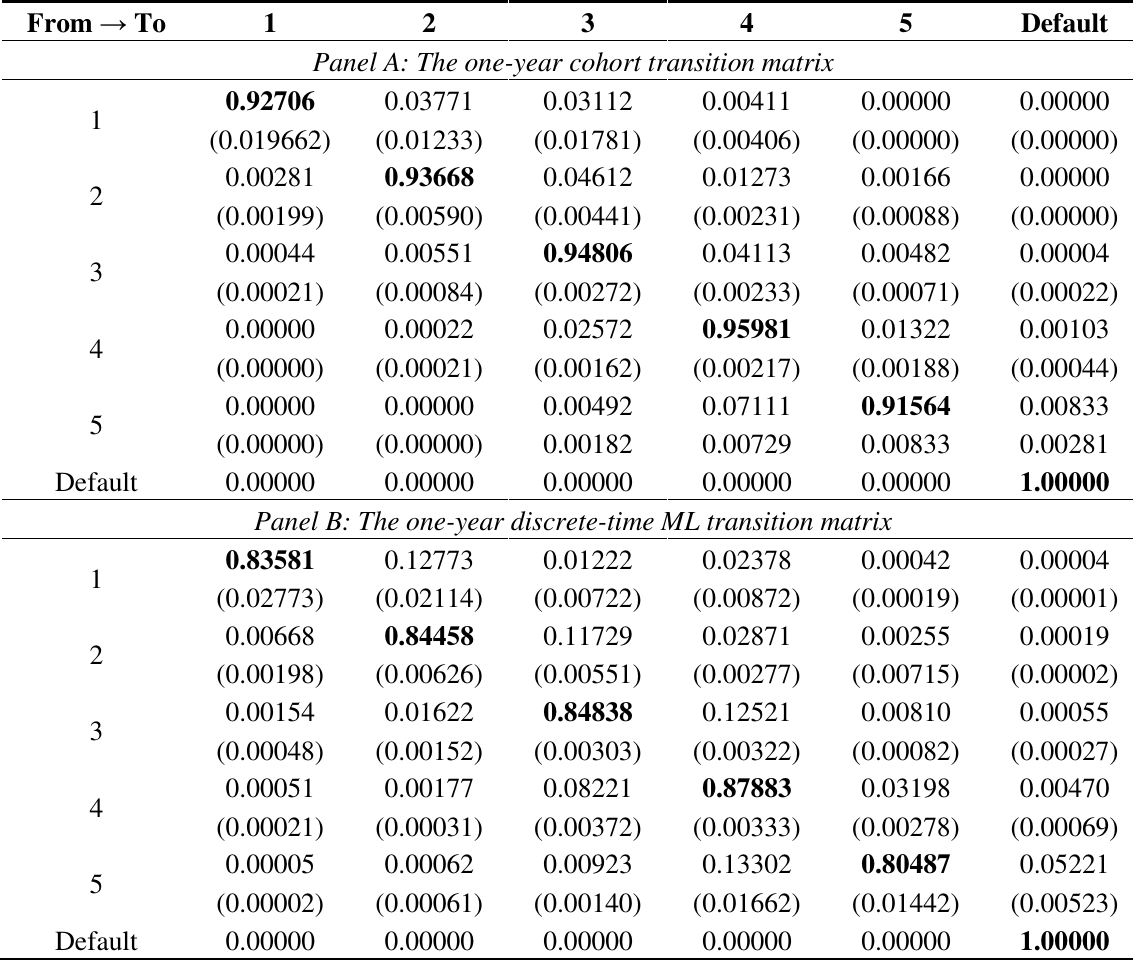
Table 2. Transition probabilities in time-homogeneity: Sub-sample—domestic obligors only. From →